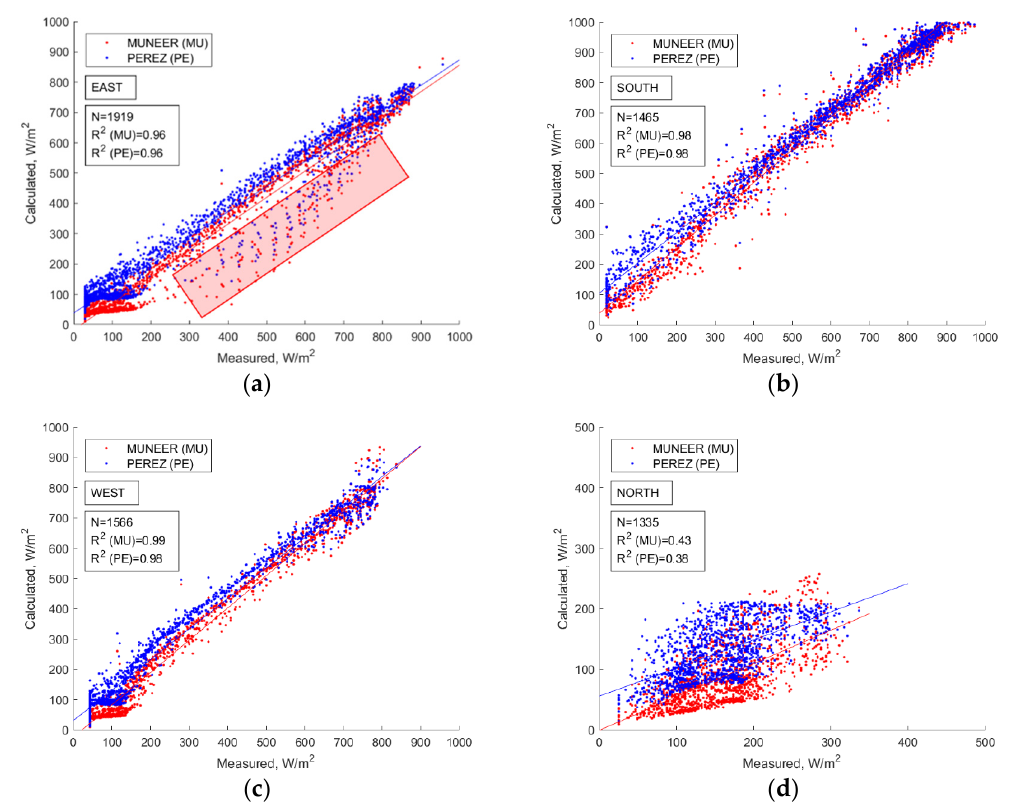
Figure 4. Correlation between calculated (based on BF5 pyranometer data) and measured (with CMP3 pyranometer) applying Perez (PE) and Muneer (MU) transposition models. ( a ) East; ( b ) South; ( c ) West; ( d ) North. Figure ( a ) shows high deviation between estimated and measured values, indicated by a red rectangle, generated by shadows at dawn. Table 3. Results of the comparison of calculated and measured irradiance data at four different orientations (E, S, W, N) in the period between 25 January 2019 and 11 April 2019 for the experimental testing ground station in Spain (time intervals every 5 min).